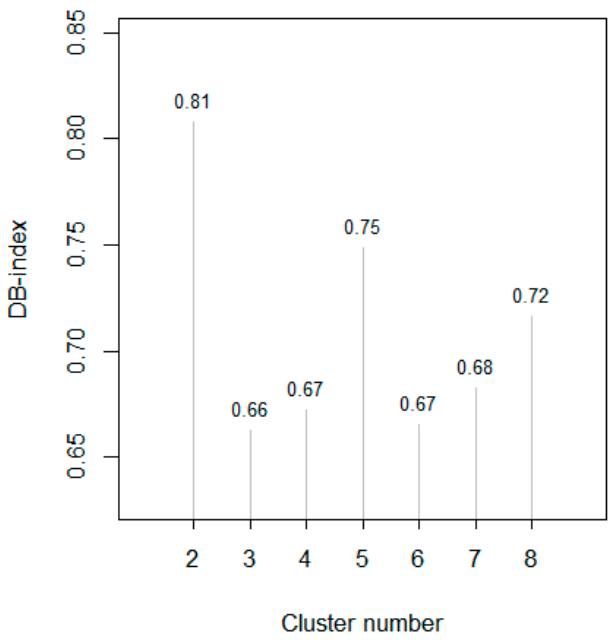
Figure 2. Davies–Bouldin (DB) indexes for cluster number ranging from 2 to 8.